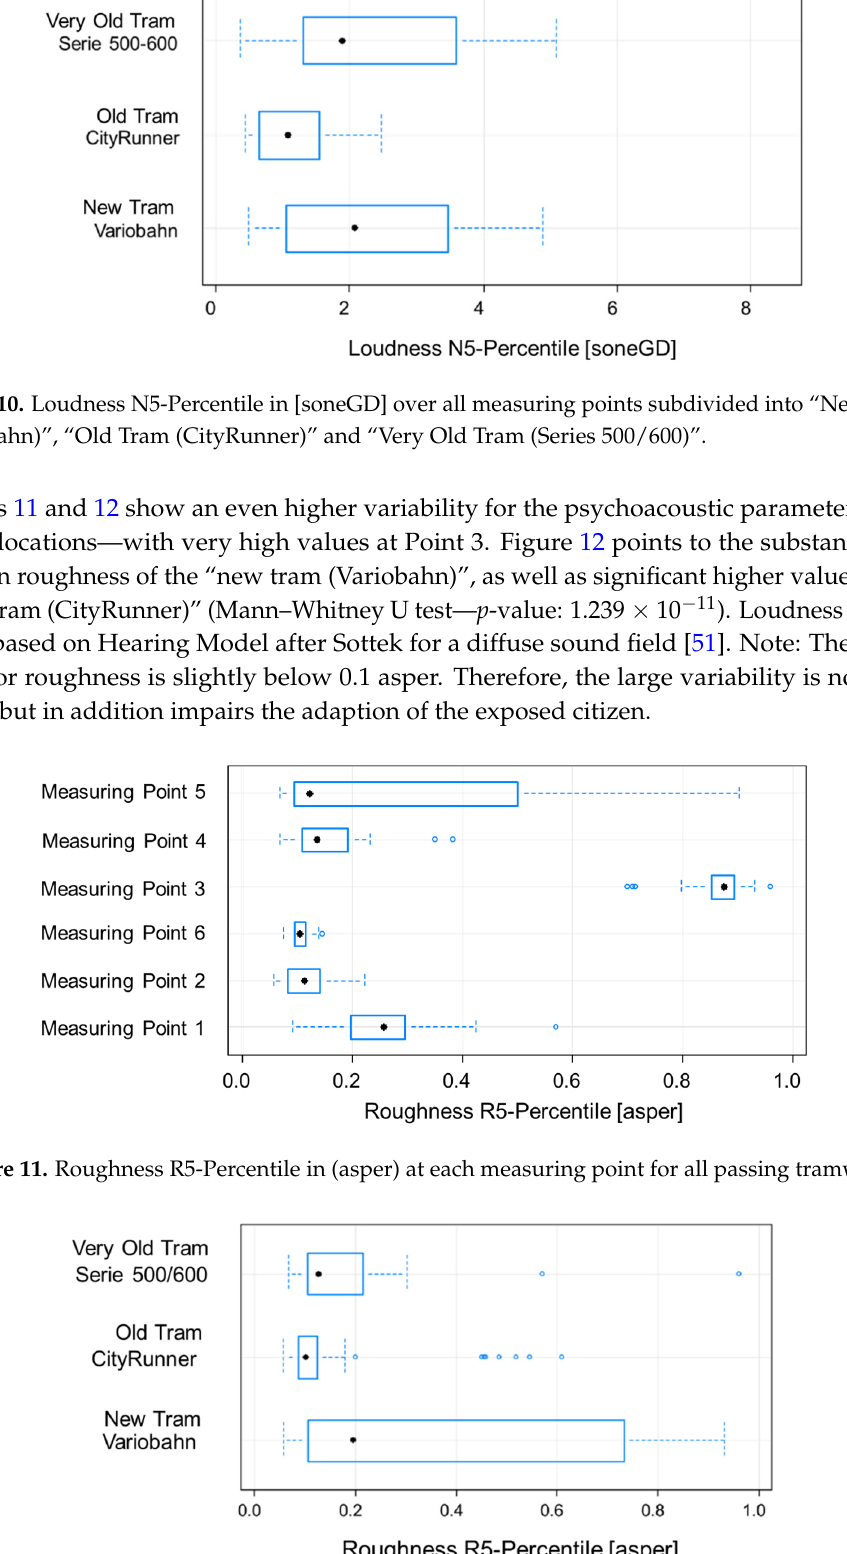
Figure 12. Roughness R5-Percentile in (asper) over all measuring points subdivided into “New Tram (Variobahn)”, “Old Tram (CityRunner)” and “Very Old Tram (Series